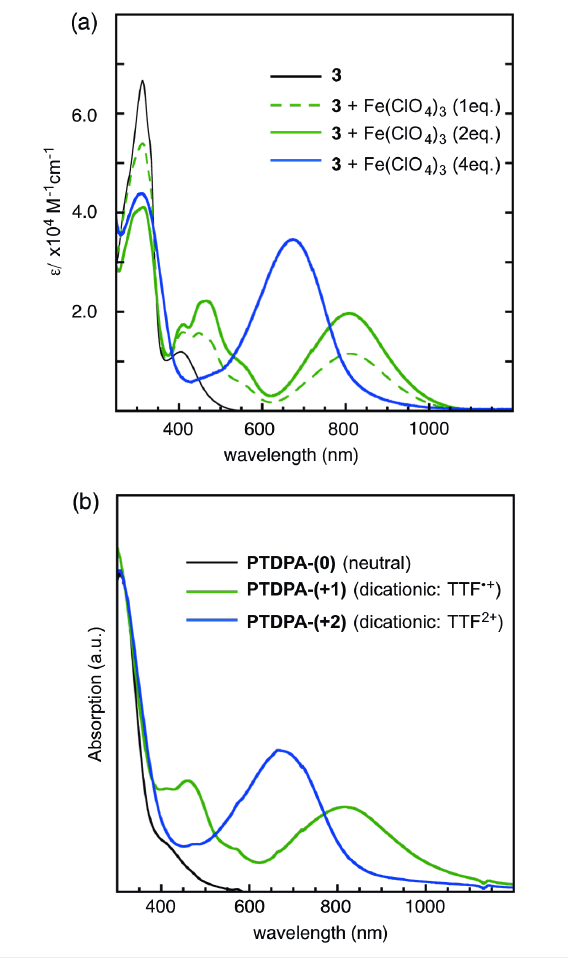
Table 1: Redox potentials of 3 and PTDPA. a Compound E 1 1/2 E 2 1/2 3 − 0.01 0.31 PTDPA 0.03 0.30